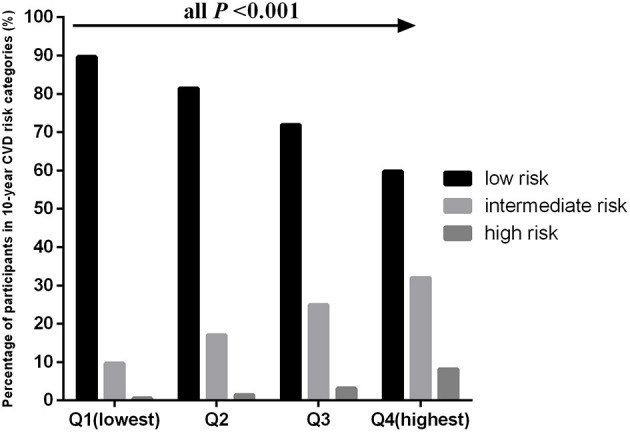
Percentages of 10-CVD risk categorize compared across the quartiles of the TyG index.